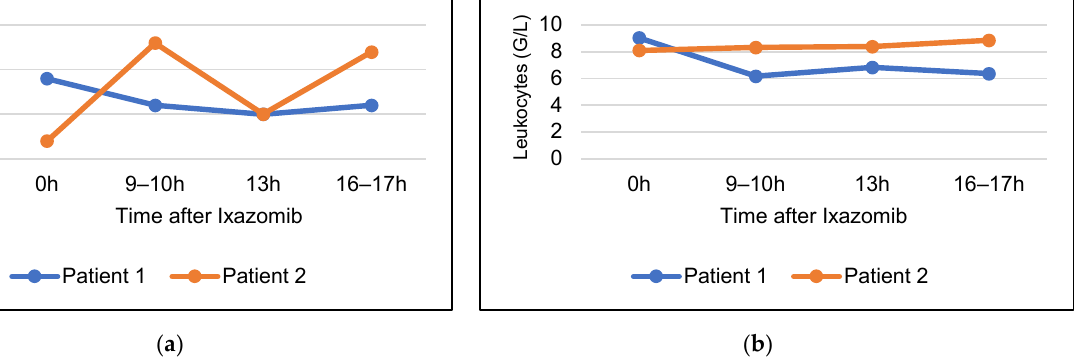
Figure 1. Modifications in ( a ) CD34+ cells and ( b ) leukocytes levels in two patients following administration of ixazomib.